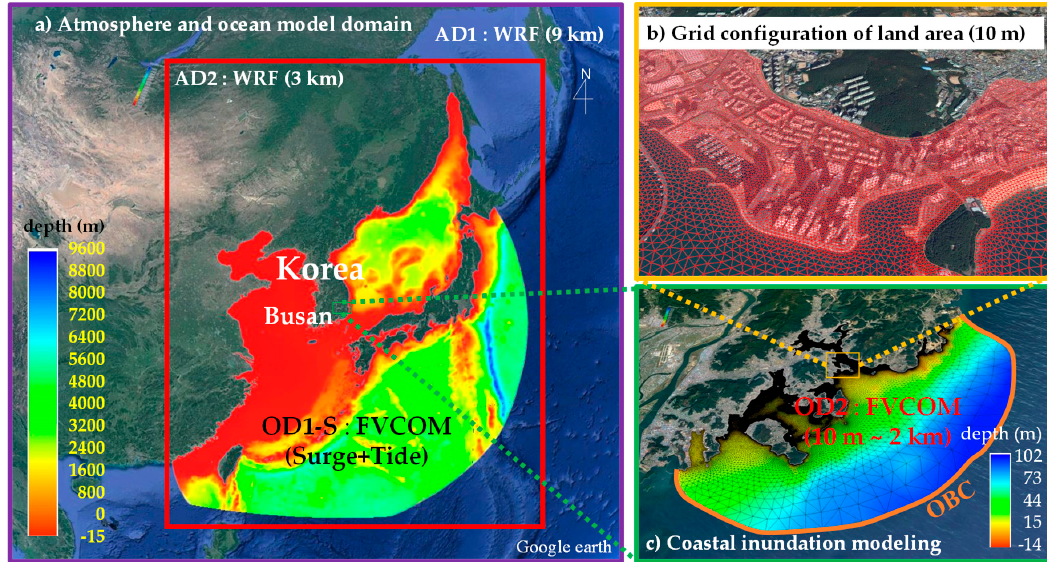
Figure 2. Model description for simulation of typhoon-induced coastal inundation (AD: Atmosphere Domain, OD: Ocean Domain) .